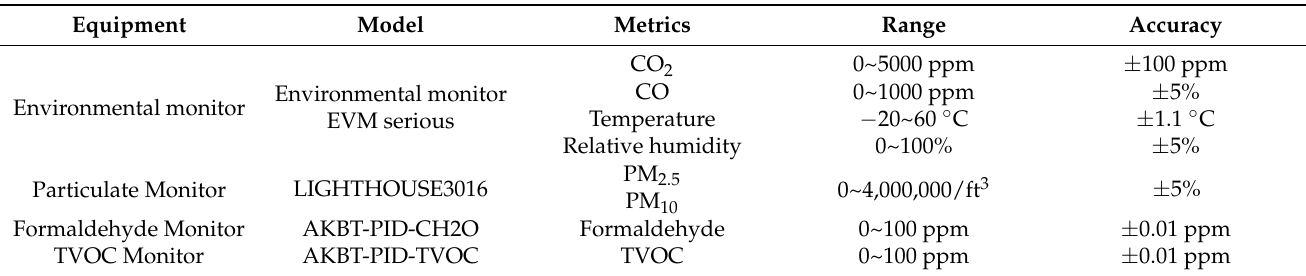
Table 1. Introduction of test